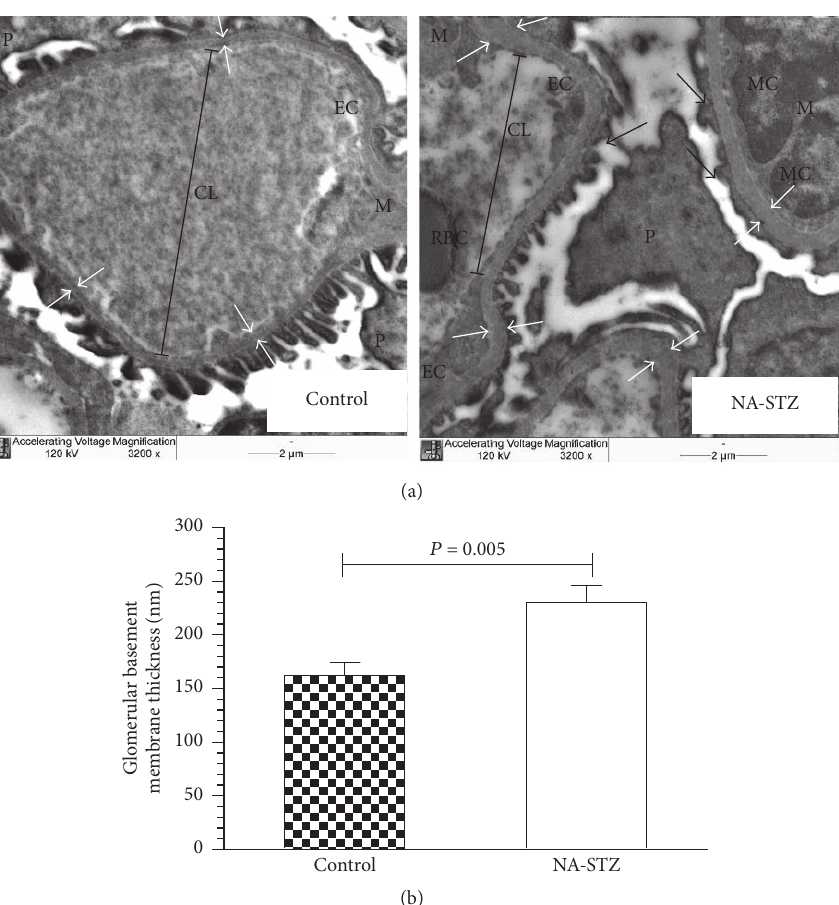
Figure 8: Transmission electron microscopic examination of the glomerular basement membranes (GBM) in control and NA-STZ-induced diabetic groups at week 20. (a) Representative electron microphotographs (magnification × 3200): white arrows indicate the thickness of the GBM; black arrows show foot process effacement characterized by loss of normal interdigitation pattern. Foot processes of the podocytes are fewer and wider; M: mesangium; EC: glomerular endothelial cell; MC: mesangial cells. Red blood cell (RBC) is seen in the capillary lumen (CL). Nicotinamide-streptozotocin-induced diabetes at week 20 caused early electron features of diabetic nephropathy such as marked irregular thickening of the capillary GBM and partial fusion of the podocytes in high-fat-fed heminephrectomized rats. The GBM of control rats is markedly thinner and no electron dense deposits are present in mesangial region. The mesangium from control nondiabetic rats is not prominent and does not compress the capillary lumen. (b) Quantification of the thickness of the GBM from control nondiabetic and NA-STZ-induced diabetic groups. Mean values and standard deviations are